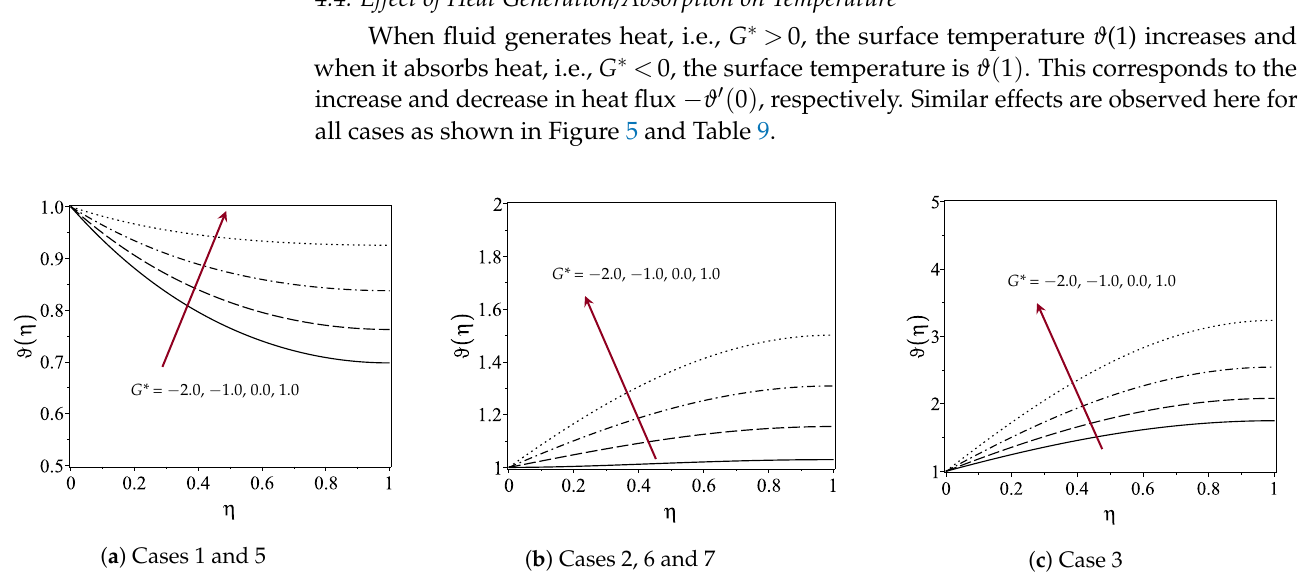
Figure 5. Variation of temperature distribution ϑ ( η ) with heat generation/absorption parameter G ∗ at S =4 and Pr